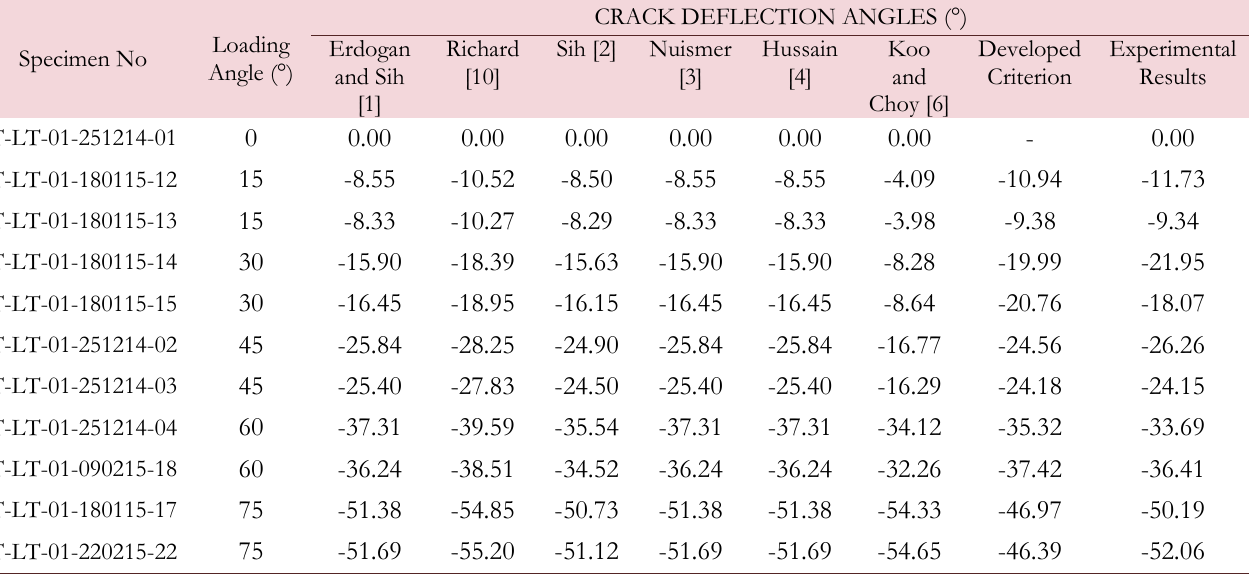
Table 8: Comparison of the predicted crack deflection angles using the developed criterion and comparison with other existing criteria in the literature, T-specimen.